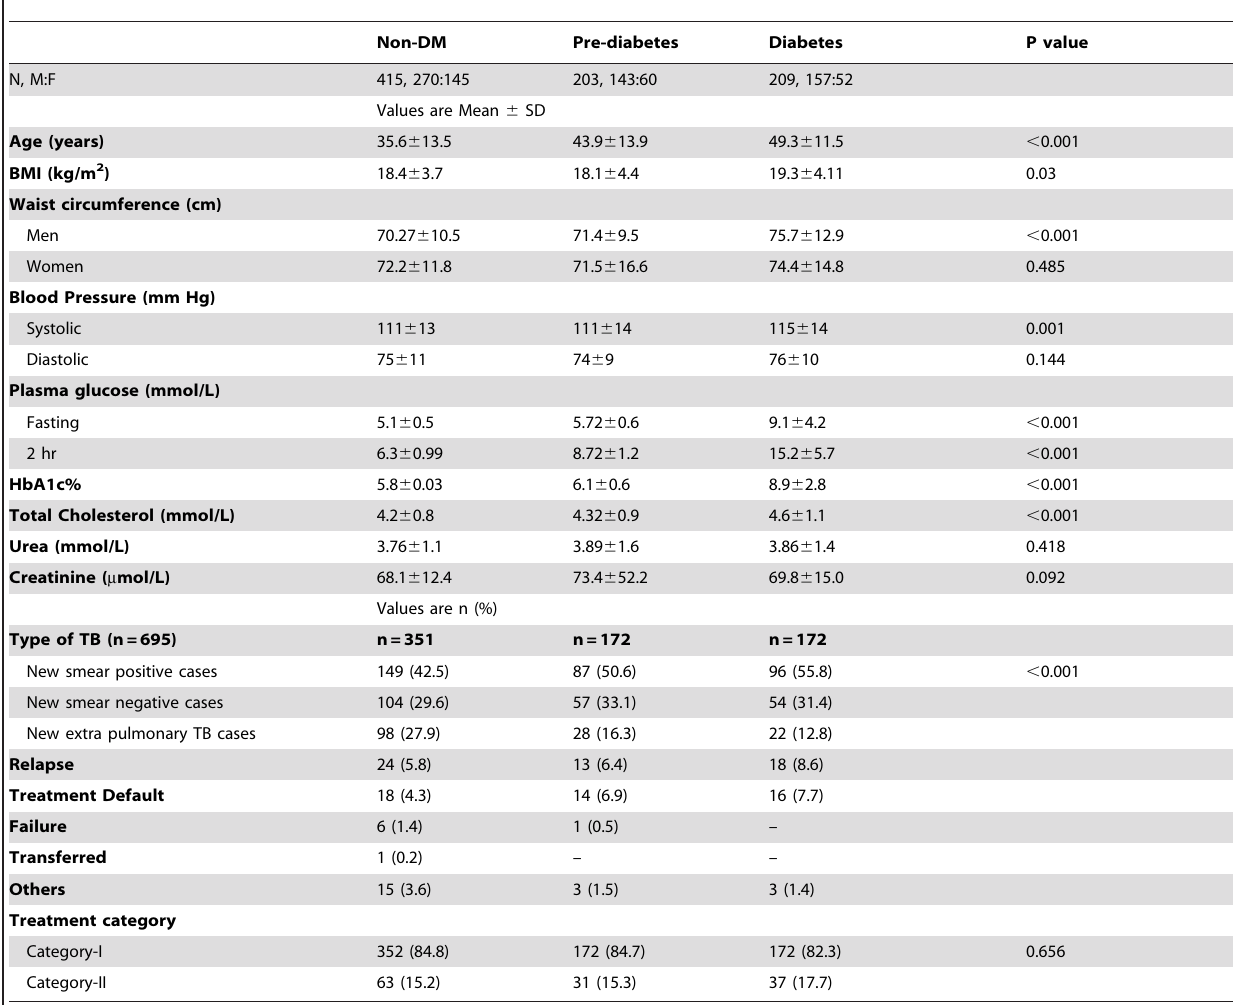
Table 3. Comparison of study characteristics among TB patients with normoglycemia, pre-diabetes and